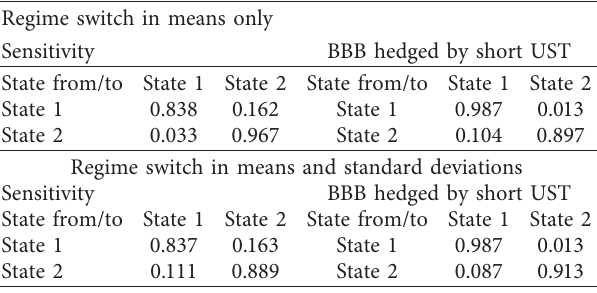
Table 2: Transition probabilities between state 1 and state 2 for all models.